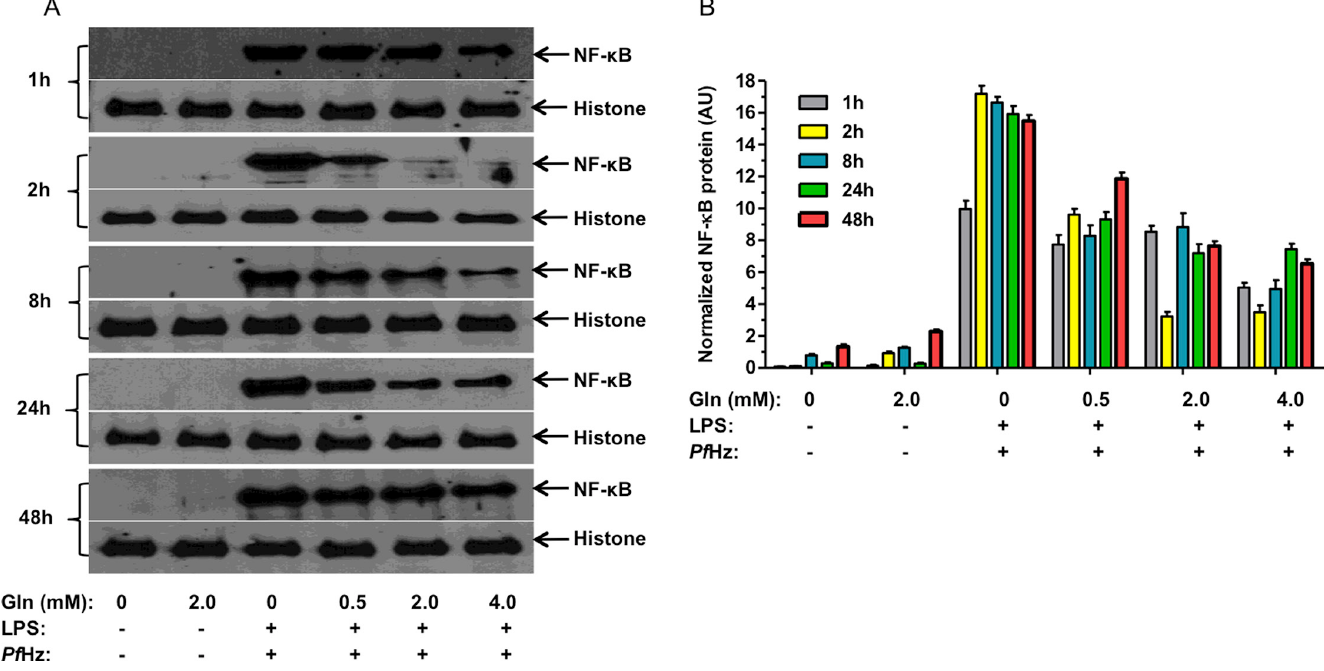
Figure 7. Effect of Pf Hz and glutamine on NF- κ B translocation into the nucleus. (A) Peripheral blood mononuclear cells (2.5 × 10 6 ) were incubated with LPS for 1 h prior to the addition of Gln (0.5, 2.0 and 4.0 mM, pretreated 30 min prior to adding Pf Hz) for different time points. Nuclear extracts were prepared after harvesting cells at stipulated time points and equal amount of protein was loaded on 4-20% SDS-PAGE to determine the amount of nuclear translocated NF- κ B protein by immunoblotting. In addition, a nuclear marker (histone protein) was quantified to account for protein loading (control). (B) Densitometry analysis after normalizing the respective bands against histone (n = 3); error bars represent